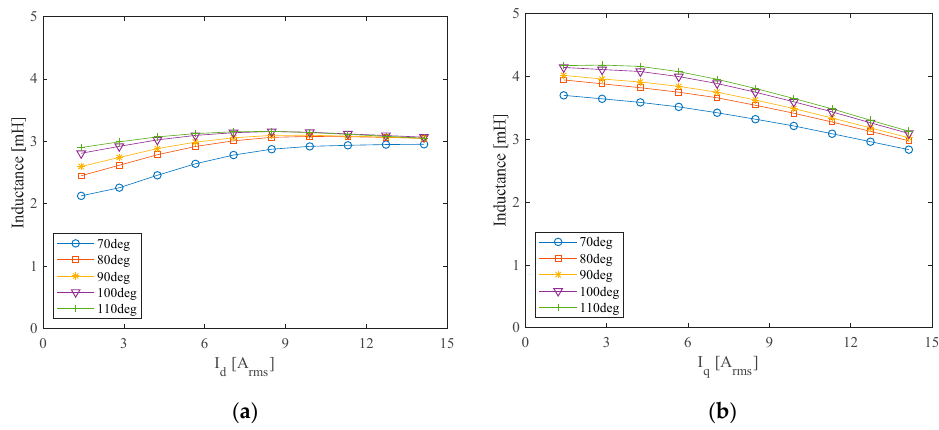
Figure 10. D and q-axis inductances: ( a ) d-axis inductance, ( b ) q-axis inductance.